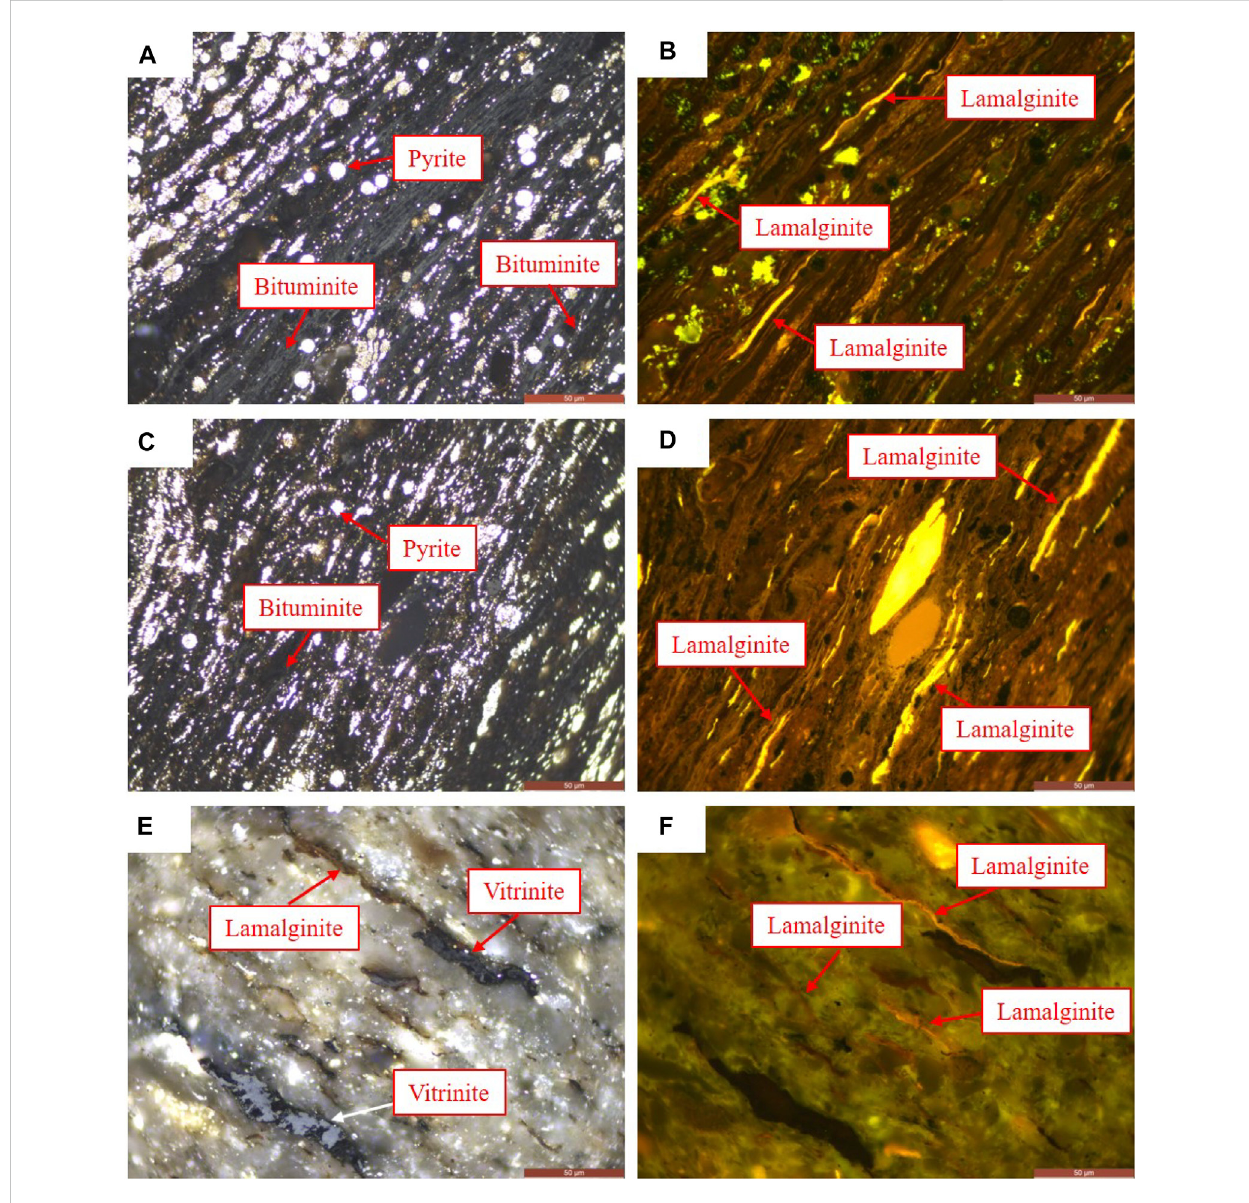
FIGURE 13 Organic macerals in source rocks from the study area, including lamalginite, bituminite and vitrinite; (A,C,E) under re fl ected light; (B,D,F) under fl uorescent light.